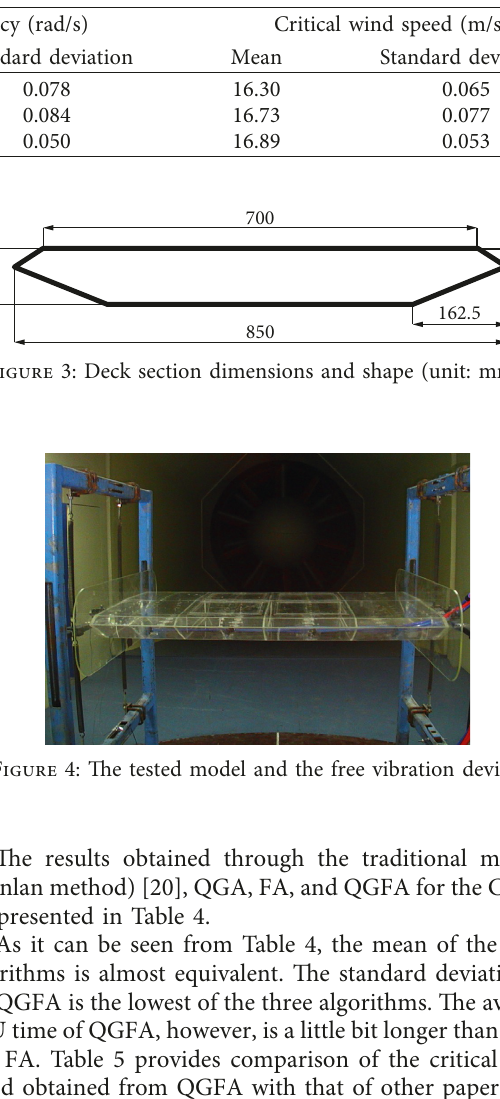
Table 3: Comparison of computational results (flat plate).